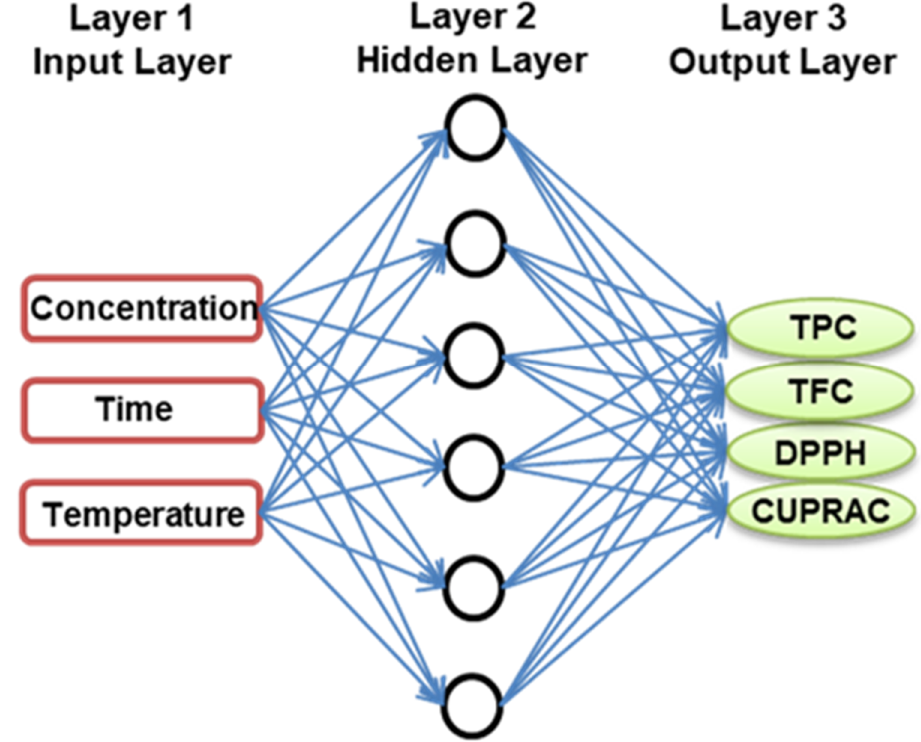
Figure 5. Optimal topology of a developed ANN model.